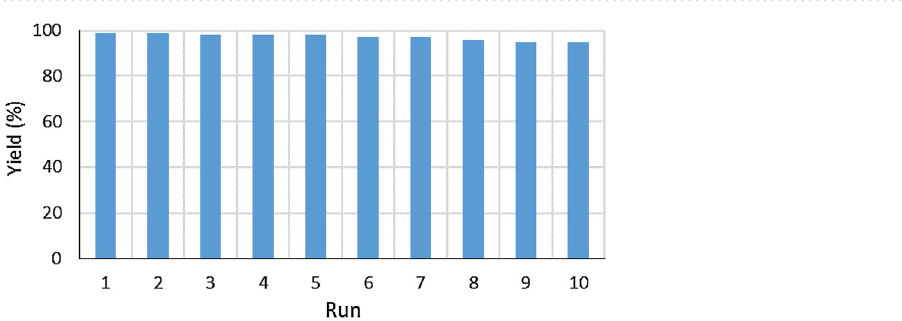
Figure 8. ( a ) Dispersion of γ-Fe 2 O 3 @MBD/Pd-Co in the aqueous media, ( b ) distribution of γ-Fe 2 O 3 @MBD/ Pd-Co in water/EtOAc and ( c ) isolation of γ-Fe 2 O 3 @MBD/Pd-Co by an external magnet.